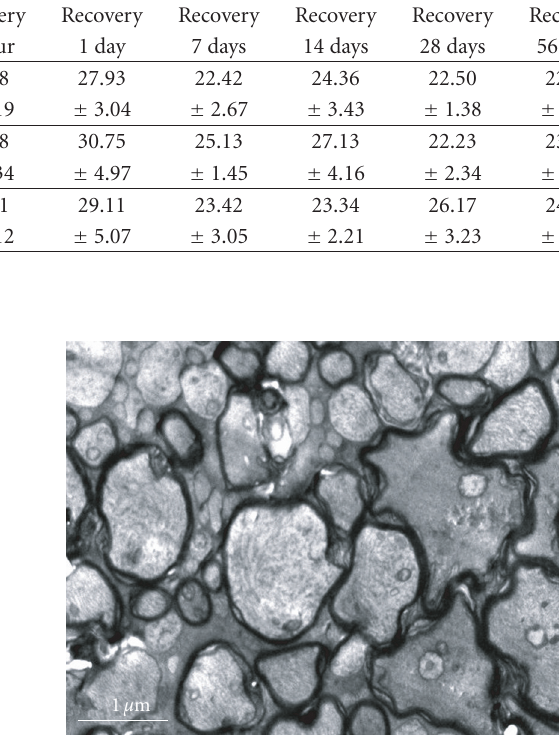
Figure 4: Shortly after suction 20 seconds, optic nerve fiber marrow scabbard is integrity, a little marrow scabbard evacuation, canaliculus and tiny threads are clear ( × 10 000).